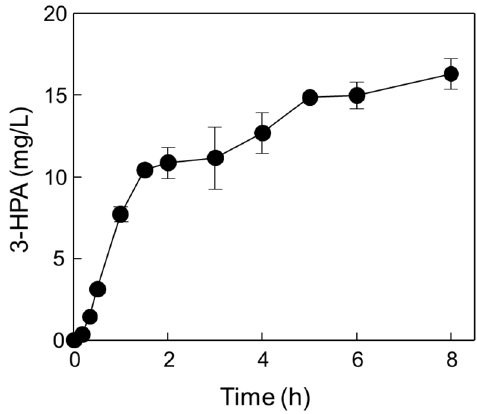
Figure 7. One-pot production of 3-HPA from methanol and ethanol by DERA Tma and MDH Lx under